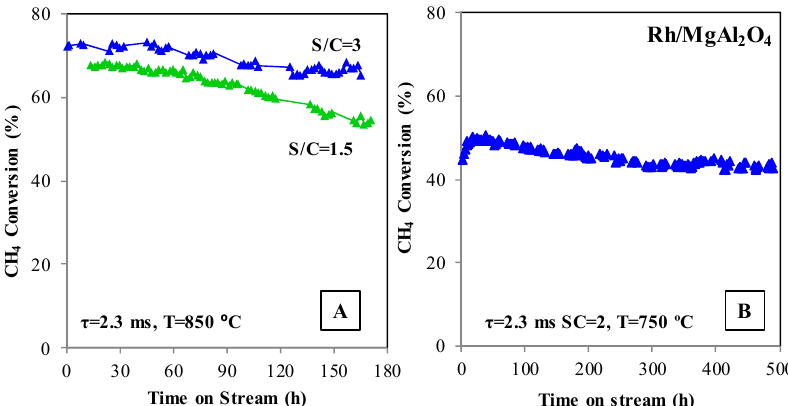
Figure 8. Methane conversion vs. TOS over Rh / MgAl 2 O 4 catalyst as a function of steam / carbon molar feed ratio at 850 °C ( A ), and at 750 °C for 500 h TOS ( B ).